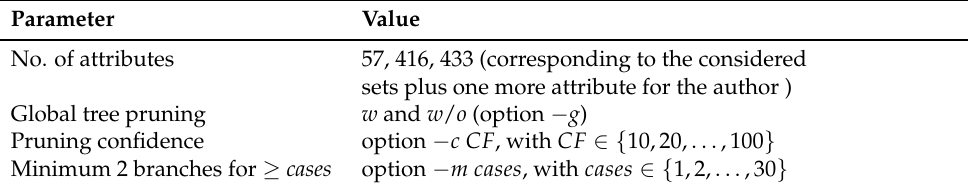
Table A4. Parameters for decision trees with C5.0.